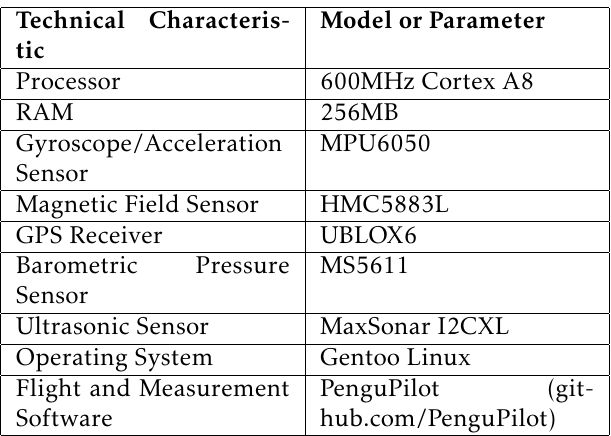
Figure 3. Received signal strength vs. distance. Table 4. Technical parameters of